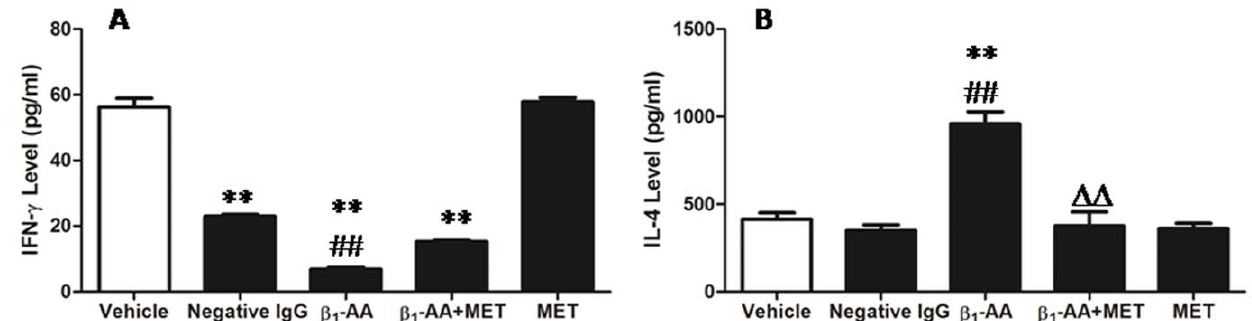
Figure 7. b 1 -AA inhibited IFN- c secretion and promoted IL-4 production in T cells. A. T cells (5 6 10 5 cells/ml) were pretreated with 1 m mol/ l metoprolol in the presence of b 1 -AA (25 m g/ml) for 48 h, and then IFN- c levels were analyzed by ELISA. ** p , 0.01 versus vehicle group, ## p , 0.01 versus negative IgG group, n =9/group B. The effect of b 1 -AA (25 m g/ml) on IL-4 levels was examined by ELISA, ** p , 0.01 versus vehicle group, ## p , 0.01 versus negative IgG group, DD p , 0.01 versus b 1 -AA group, n =9 per group. Data are presented as means 6 SD of 6 independent experiments.